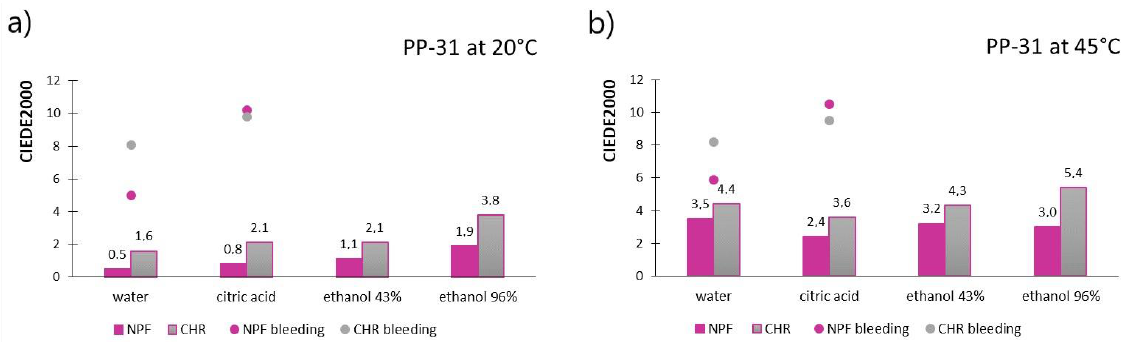
Figure 3. CIEDE2000 measured on PP-31 prints below ink’s T A ( a ) and CIEDE2000 measured on PP-31 prints above ink’s T A ( b ).